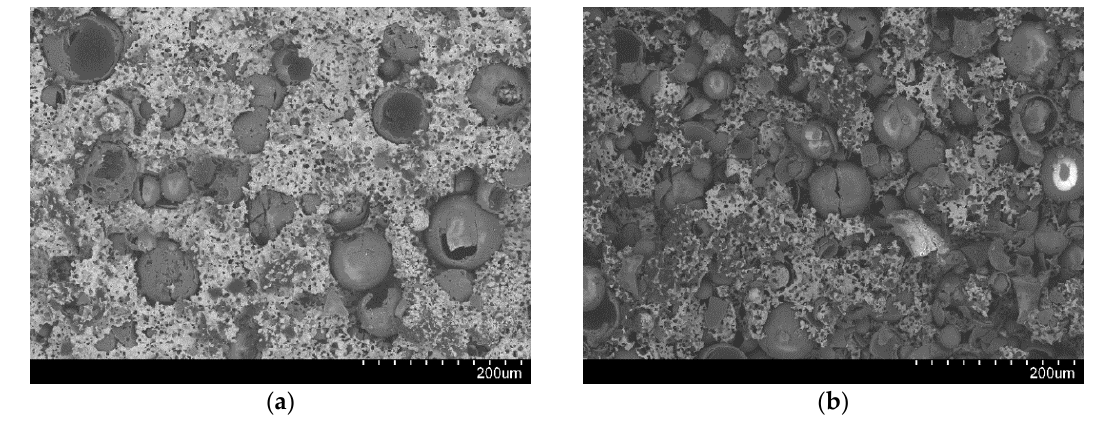
Figure 9. The plateau onset stress over density of Invar SFs in comparison to the yield strength over density of Invar matrix materials. The data of Invar SFs ‐ filled glass microballoons is reported in reference [20].